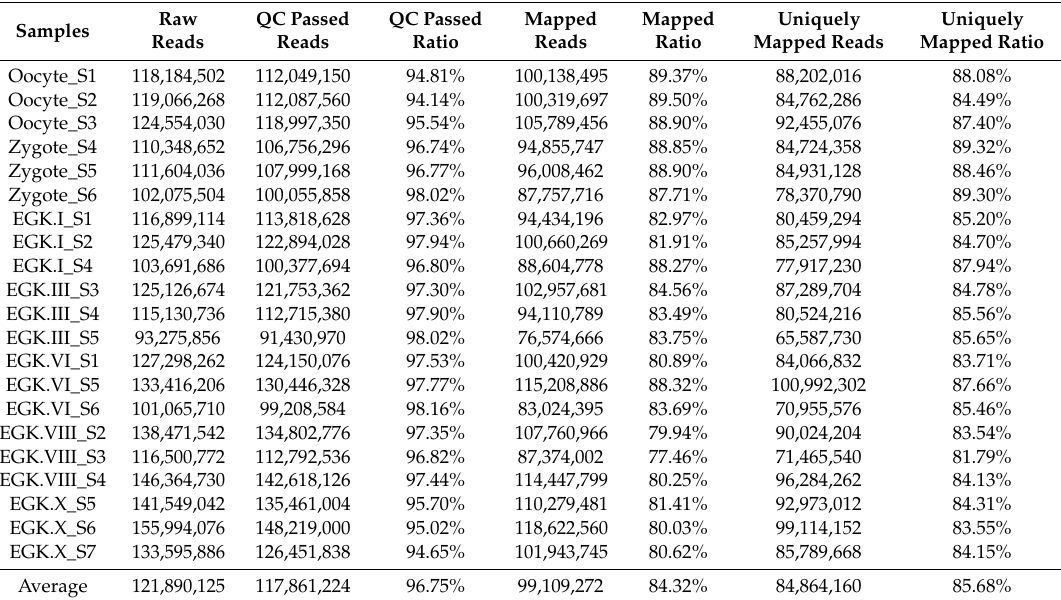
Table 1. Summary statistics of the RNA-seq